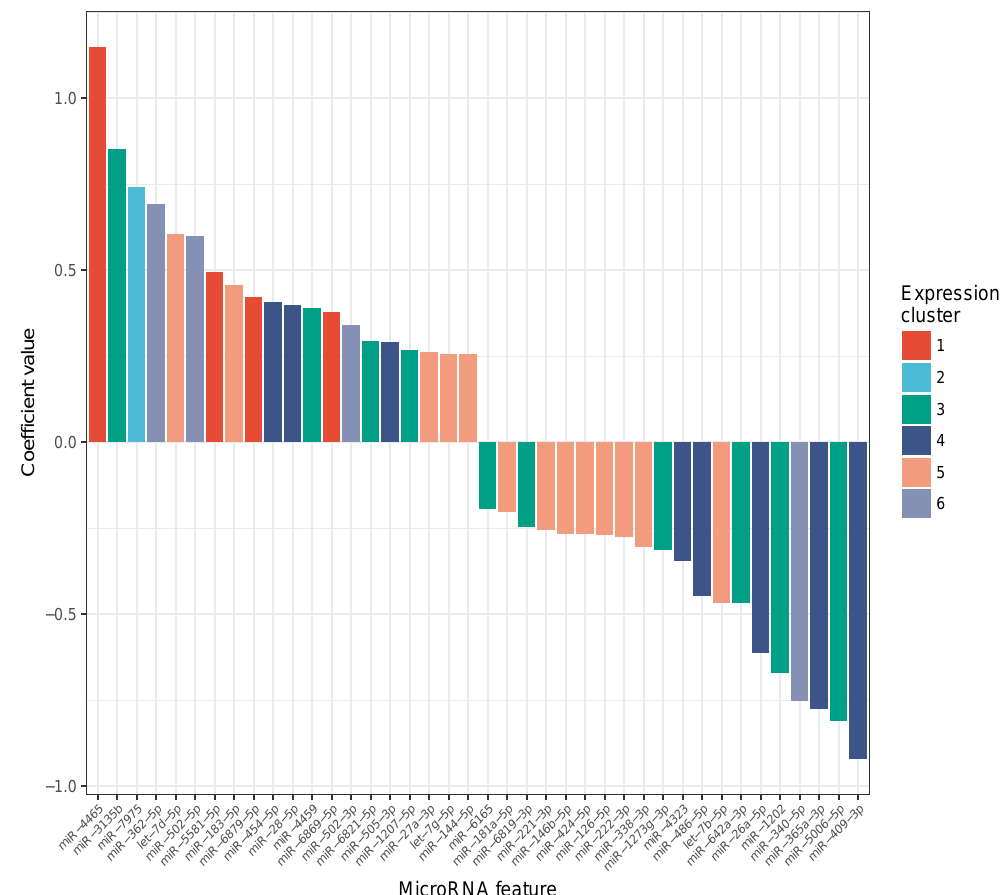
Figure 5. Top 20 positive and negative miRNA regression coefficients. Feature coefficients stem from the best linear model with respect to R 2 predicting the measured VO 2 max values. In total 86 out of 307 miRNAs were assigned a coefficient unequal from zero. Each miRNA bar is colored according to its cluster identity ( C 1 – C 6 ) from Figure 4, highlighting a differential distribution of these clusters among the most important regression